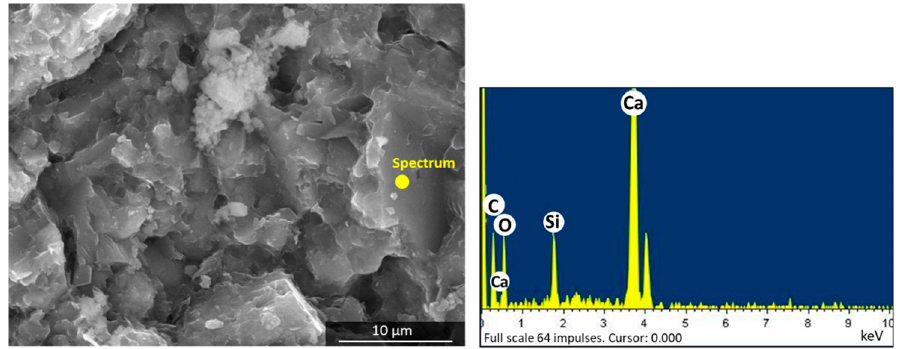
Figure 8. SEM image. Left —organo-mineral mass; right —main elements composing the organo- mineral mass.